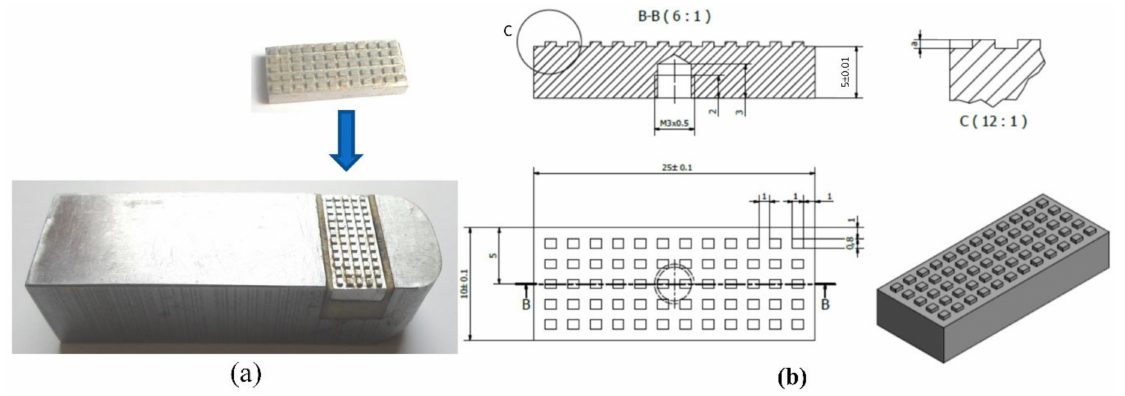
Figure 8. ( a ) block insert; ( b ) insert